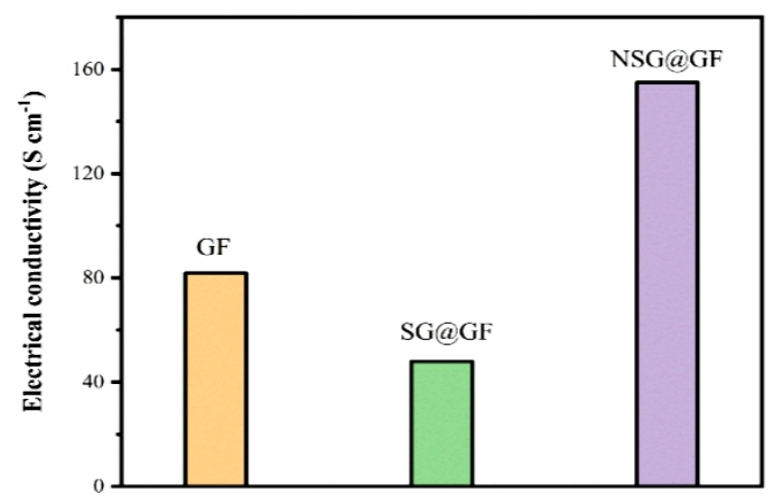
Figure 6. Electrical conductivities of GF, SG@GF, and NSG@GF.